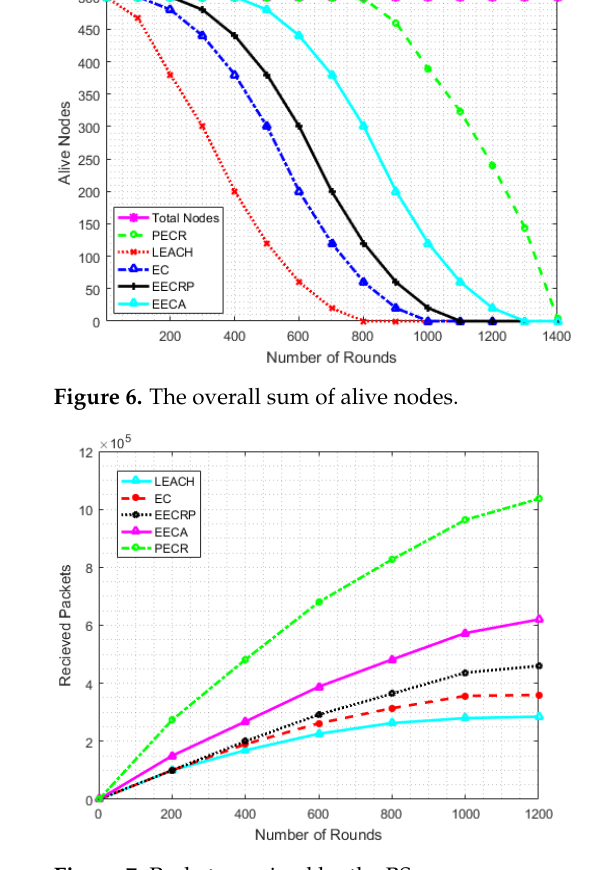
Figure 8. The residual energy of the WSN.